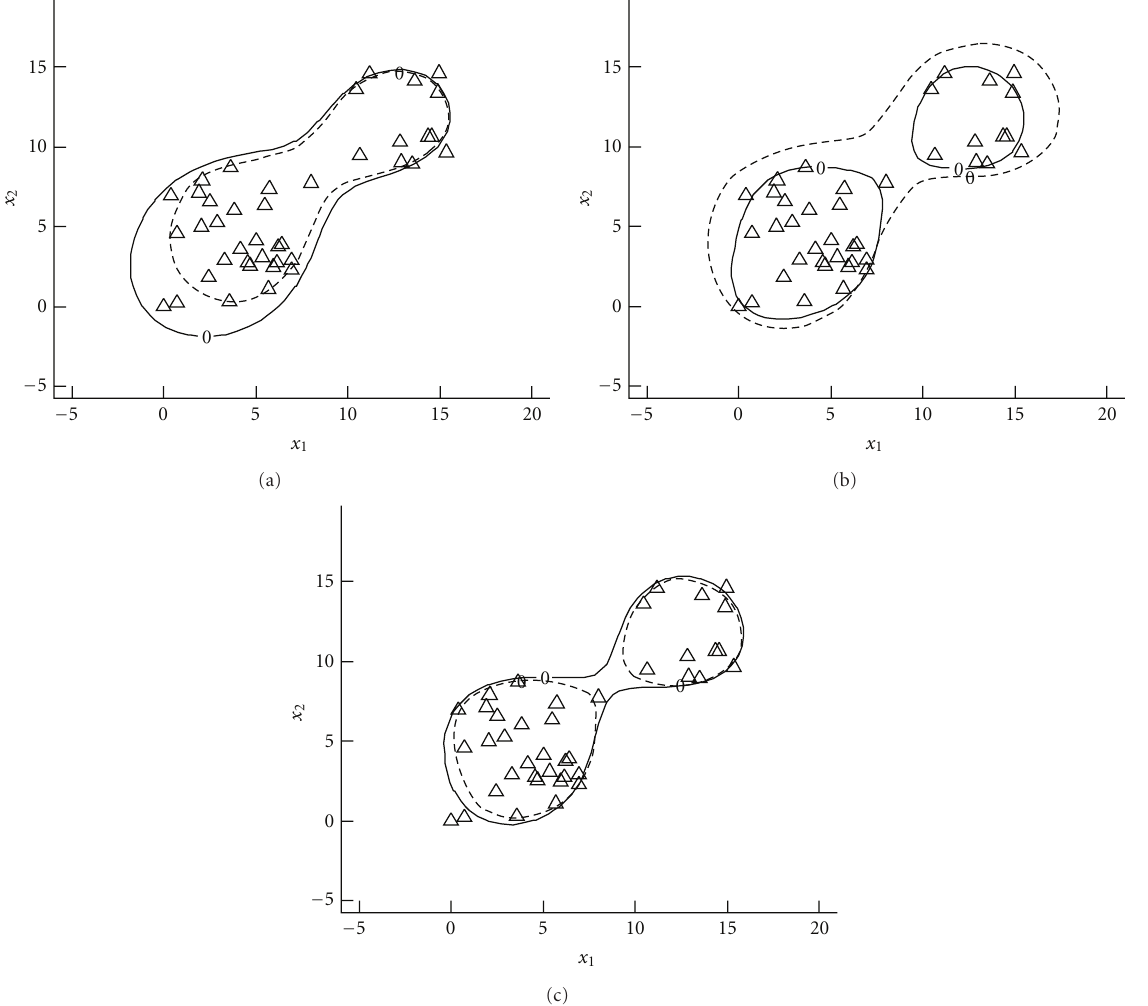
Figure 3: The contours f ( x , w ) = 0 by di ff erent values of η = 0, 0 . 5, 1 and by n = 40.